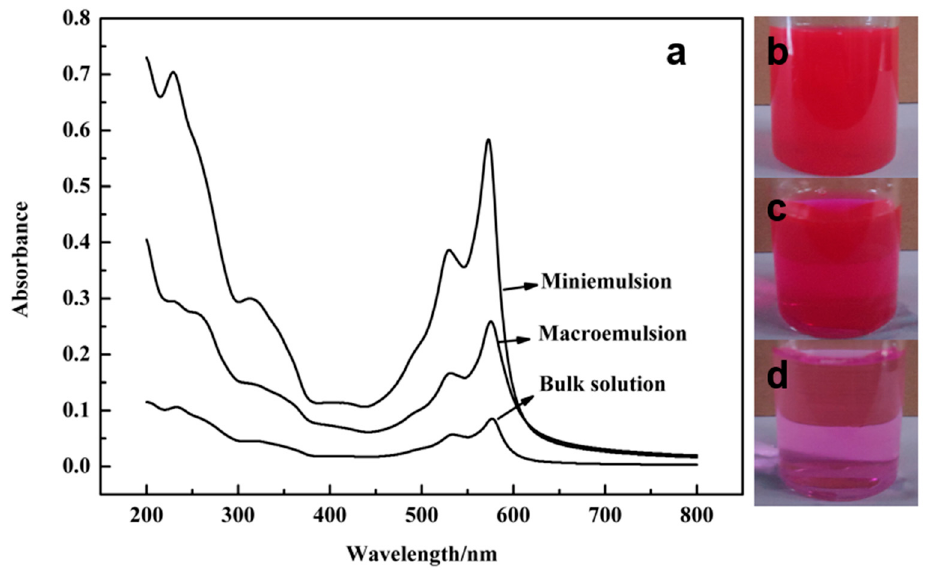
Figure 14. UV-Vis absorption spectra ( a ) and photographs of PR 146 aqueous dispersions prepared from the miniemulsion ( b ), macroemulsion ( c ), and bulk solution ( d ).